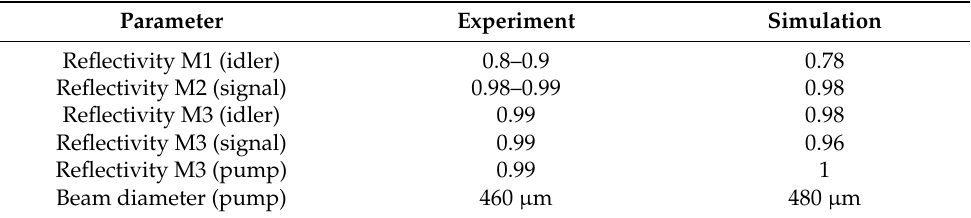
Table 3. Parameters that were adjusted in the simulation to best fit the experimental results.